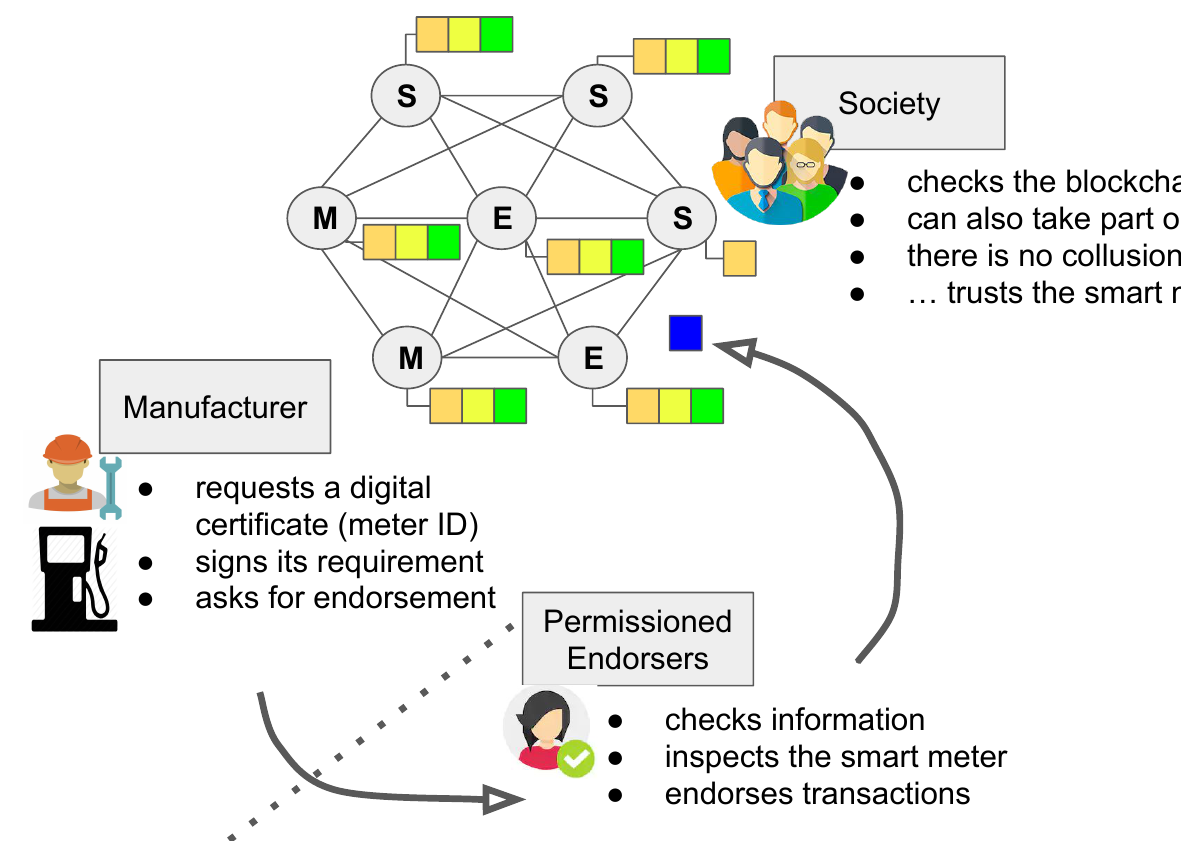
Figure 3. A blockchain-based PKI for smart meters scheme. S, Society; M, Manufacturer; E,